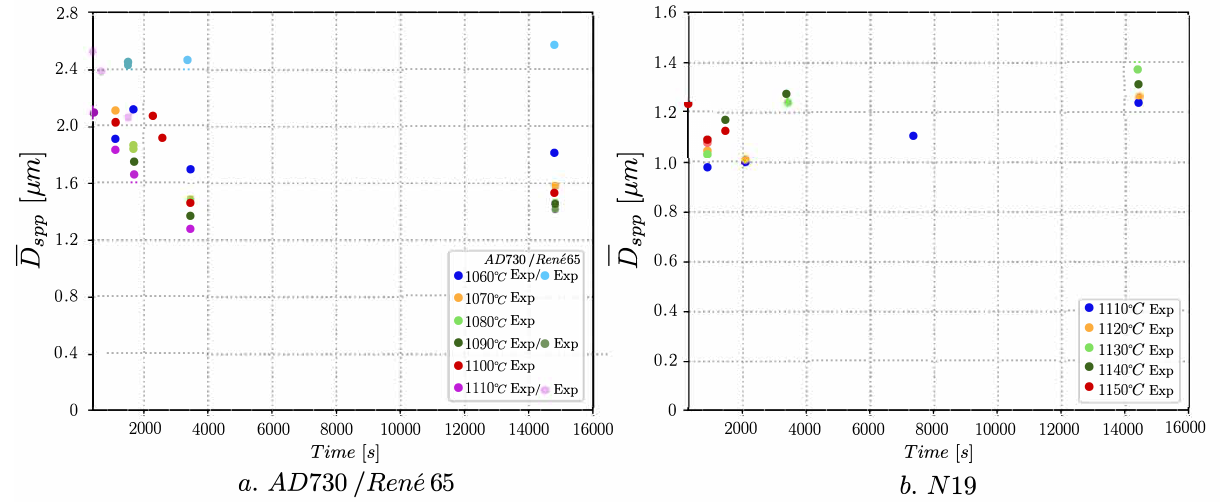
Figure 7. Mean precipitate size in the ( a ) AD 730/ René 65 and ( b ) N 19